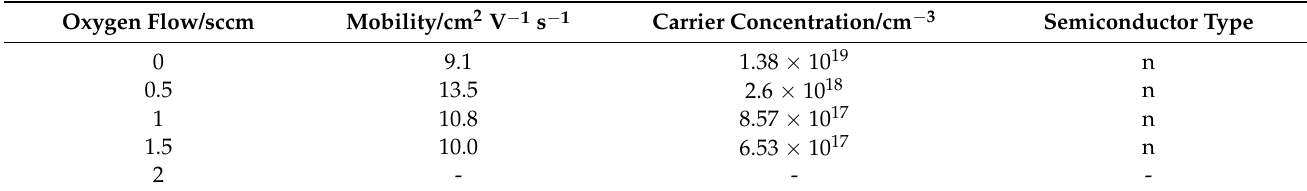
Table 3. Electrical properties of a-IGZO films under different oxygen flows.